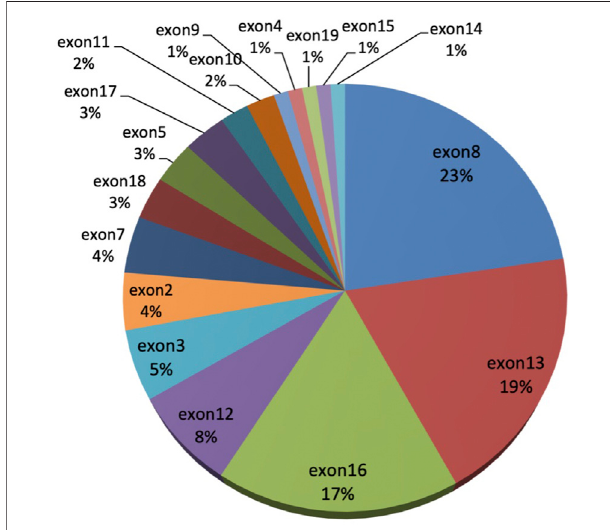
FIGURE1| Thedistribution ofATP7Bgenemutationsin47neurological WD patients.